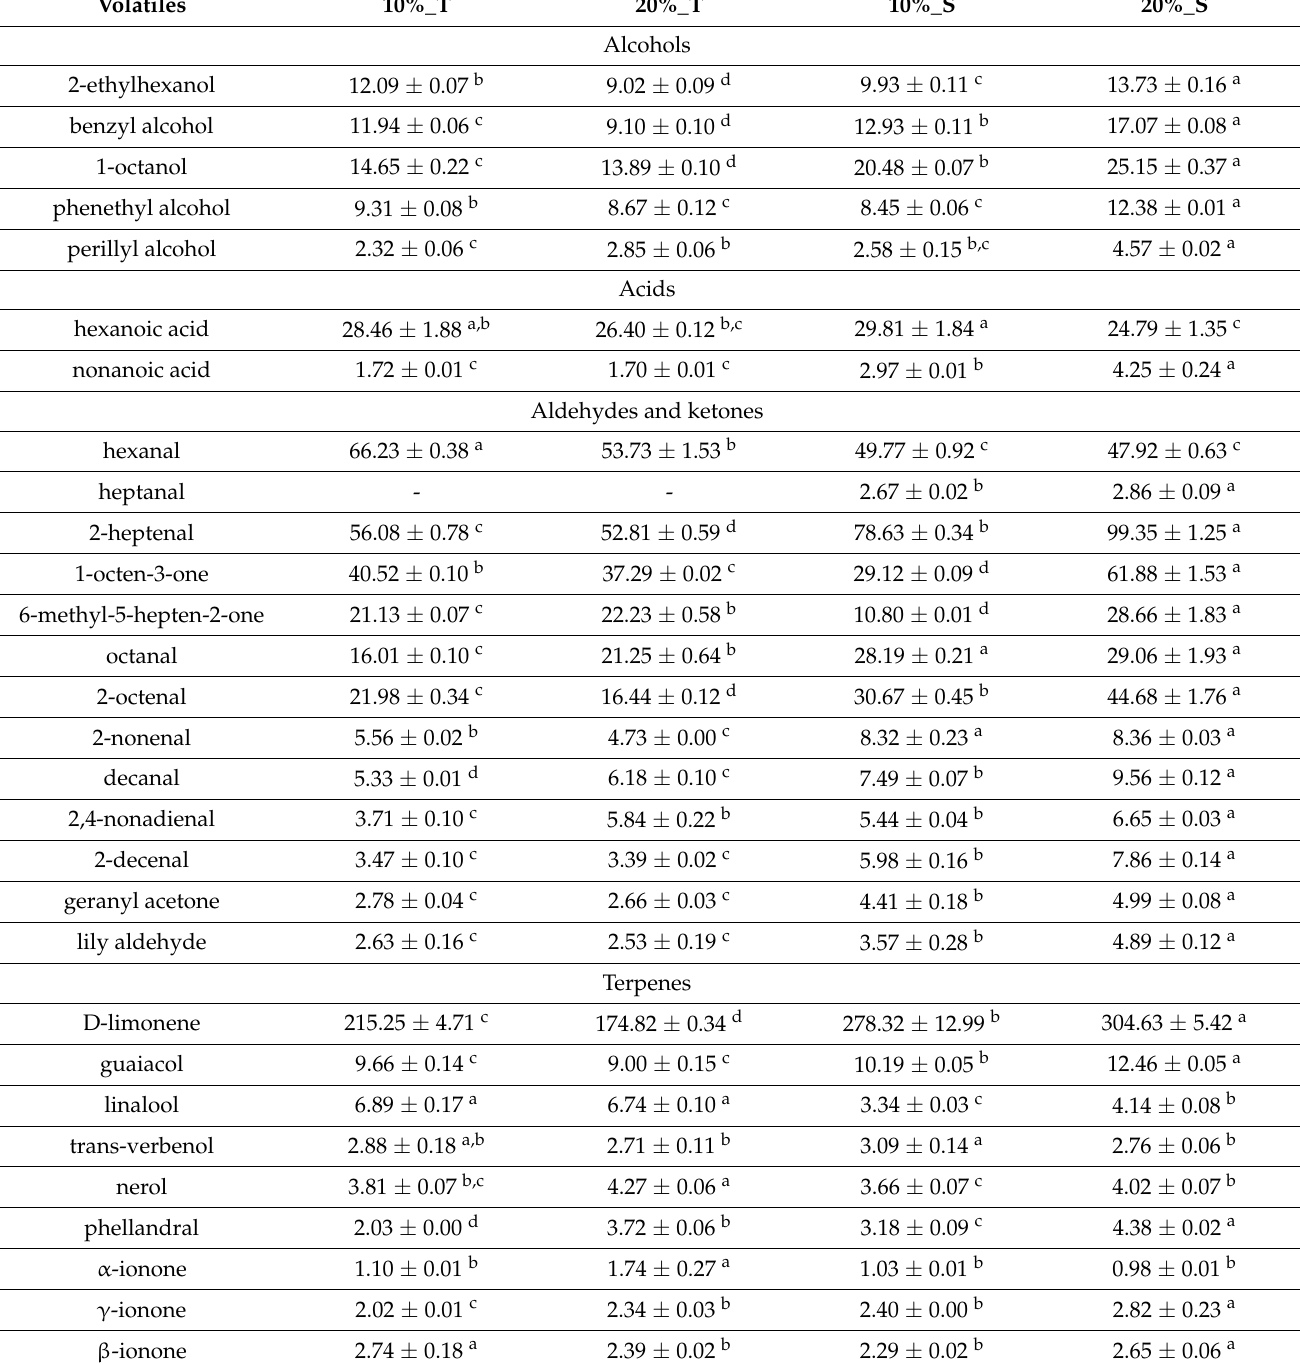
The amounts of volatiles have also been determined after storage (Table 3). All alcohols and acids were determined in higher amounts in gels with sucrose. Aldehydes and ketones were the most stable volatiles during storage, but only hexanal was determined in higher amounts in gels with trehalose. Terpenes, linalool, nerol and α -ionone were determined in higher amounts in gels with trehalose. The most abundant volatile after storage as well as after gel preparation was D-limonene, which was evaluated in the highest amount in sucrose-containing gels. Table 3. Amounts of volatiles of citrus fiber/blackberry gels prepared with different disaccharides after